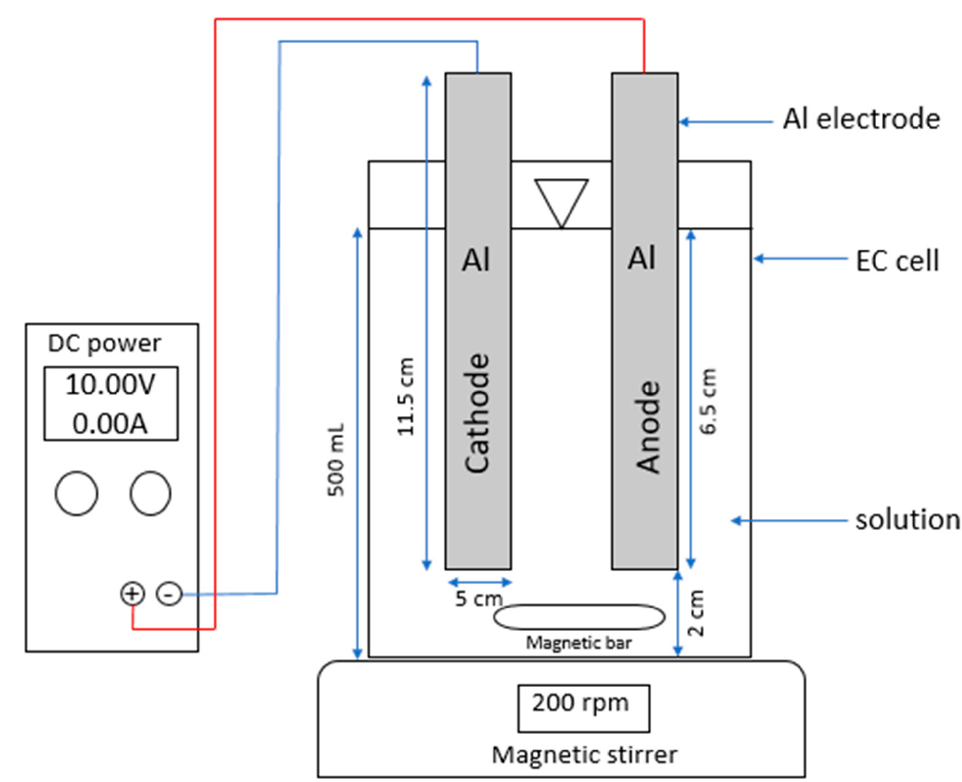
Figure 2. EC set-up.